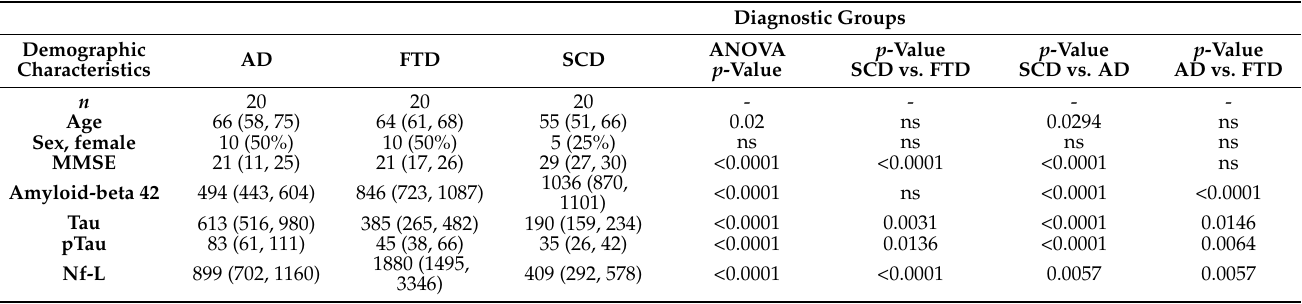
Table 3. Demographic characteristics of the clinical cohort.